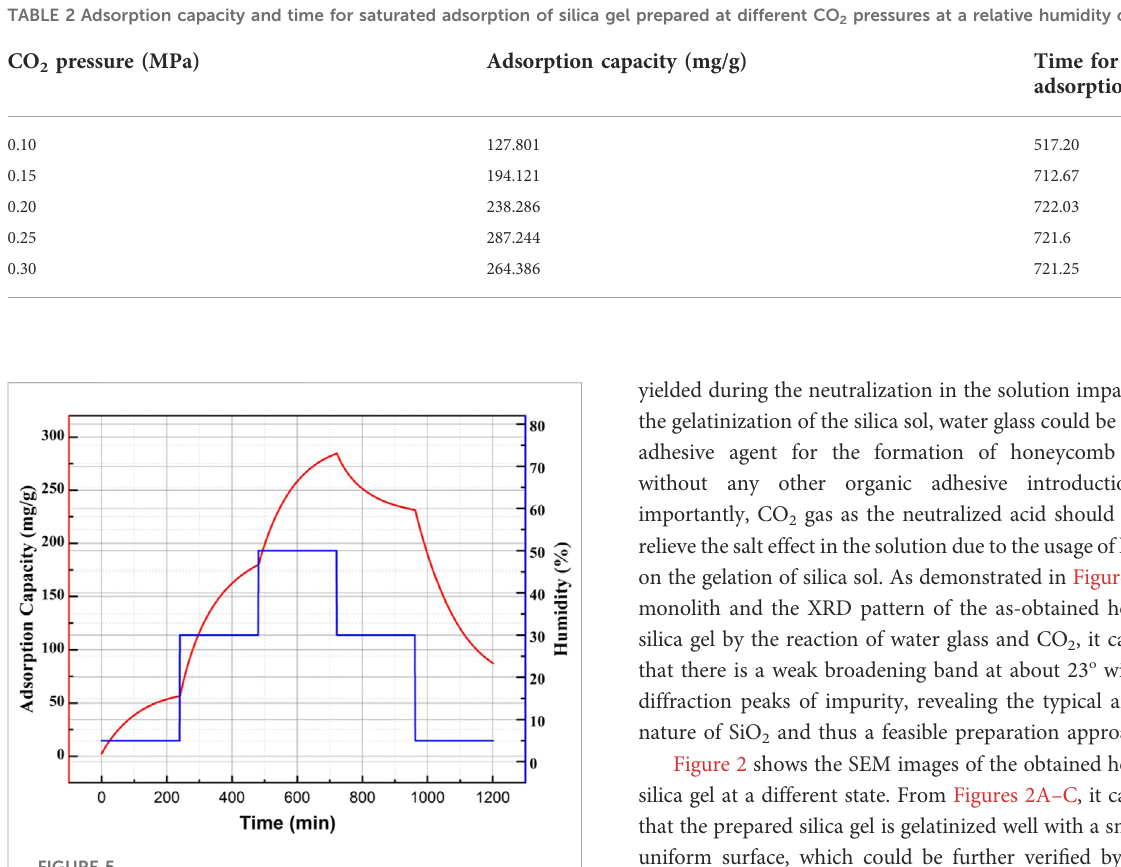
FIGURE 5 Typical adsorption/desorption kinetic curve at different humidities for the as-obtained honeycomb silica gel at a CO 2 pressure of 0.25 MPa using water glass as the starting